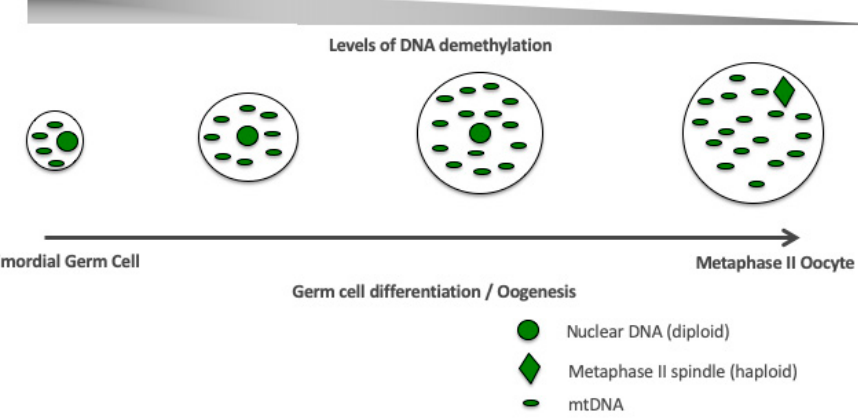
Figure 4. Germ cell differentiation . Stage-specific, synchronized interactions between the nuclear and mitochondrial genomes during germ cell differentiation and oogenesis are required to establish a viable and functional oocyte fit for fertilization (metaphase II oocyte).